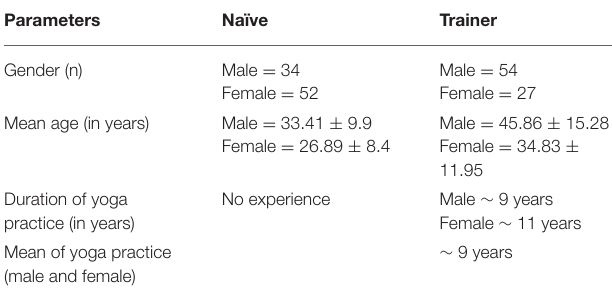
TABLE 1 | Demographic characteristics of naïve and trainer groups along with the details of the experience of yoga practice.